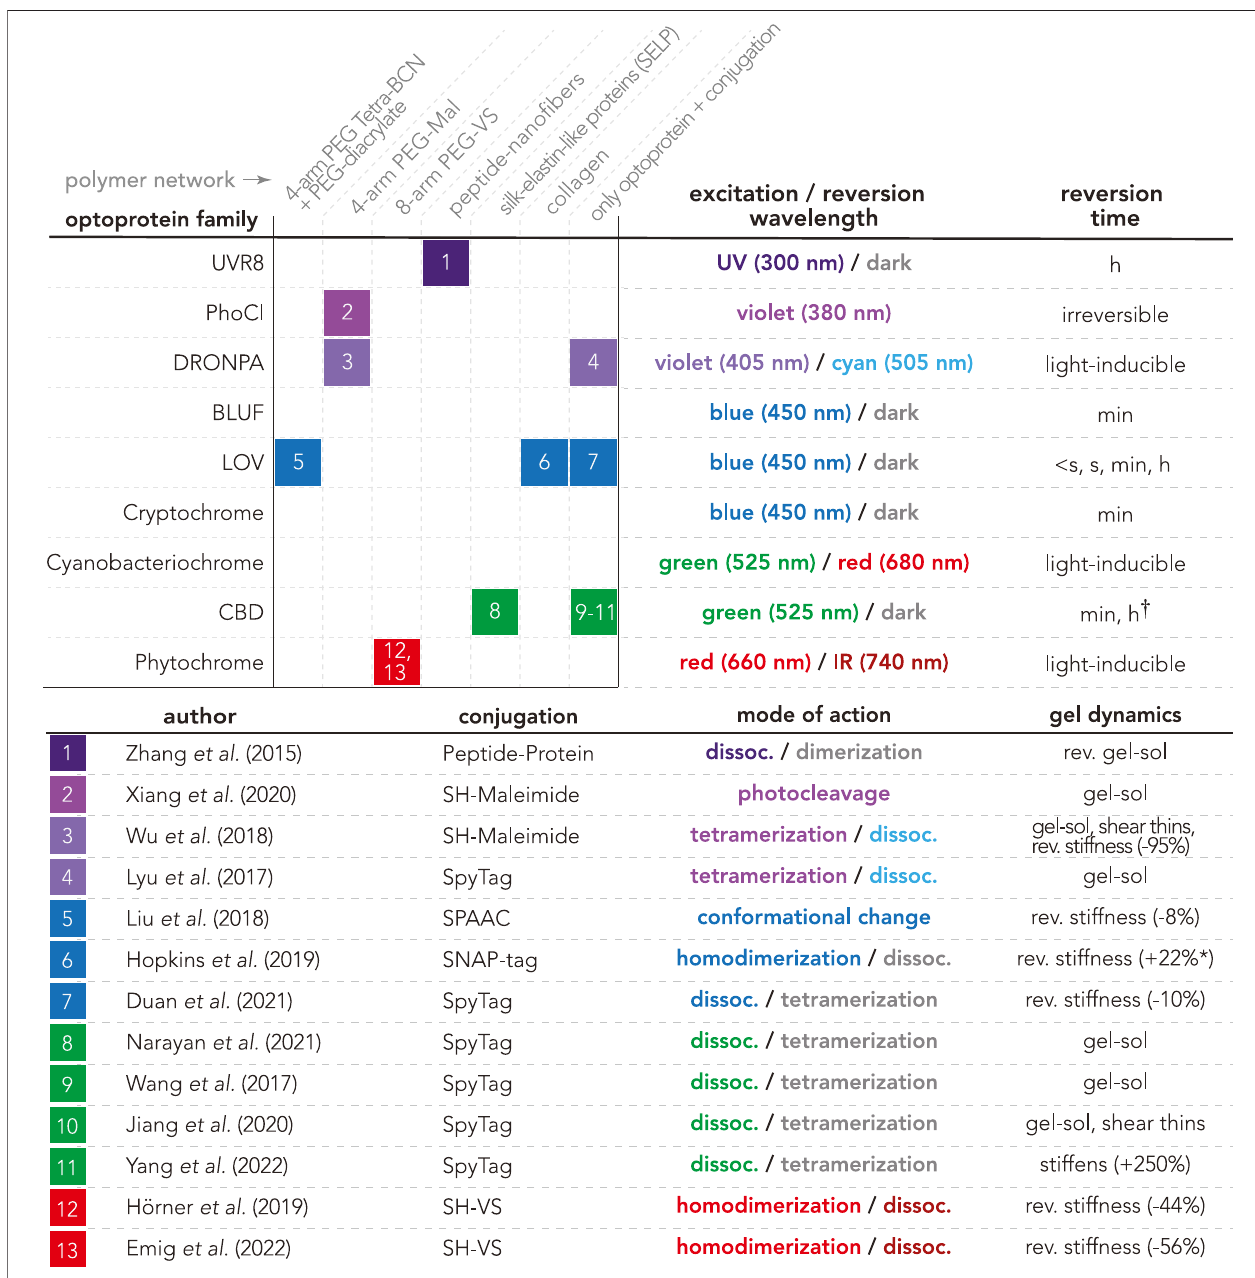
FIGURE2| OptoGel designspace,including OptoGels presented intheliterature basedoncombinationsofoptoproteins(rows)andpolymernetworks(columns). Each box is representing the OptoGel(s) referenced in the enumerated list, including information about conjugation chemistry used, mode of action (colored as the excitation/reversion wavelength, or gray for dark), as well as reported dynamic light-tunable material properties for the gel. Dynamic ranges of stiffness from AFM measurements of elastic modulus E are marked with *, and those from rheometry measurements of storage modulus G ′ are unmarked. Note that non-reported propertiescanmeanthatitwasjustnottested.OptoproteindatafromOptobase(excitation/reversionwavelengthsandreversiontimes)(Kolaretal.(2018)),andfrom(Hu et al. (2020)) marked with † .